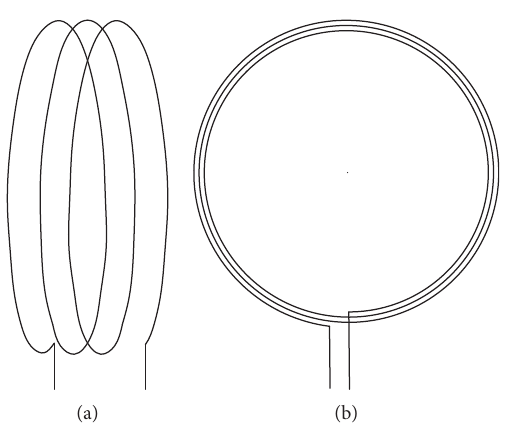
Figure 3: Structure diagram of a MCRWPT system. (a) Cylindrical spiral coil. (b) Planar spiral coil.